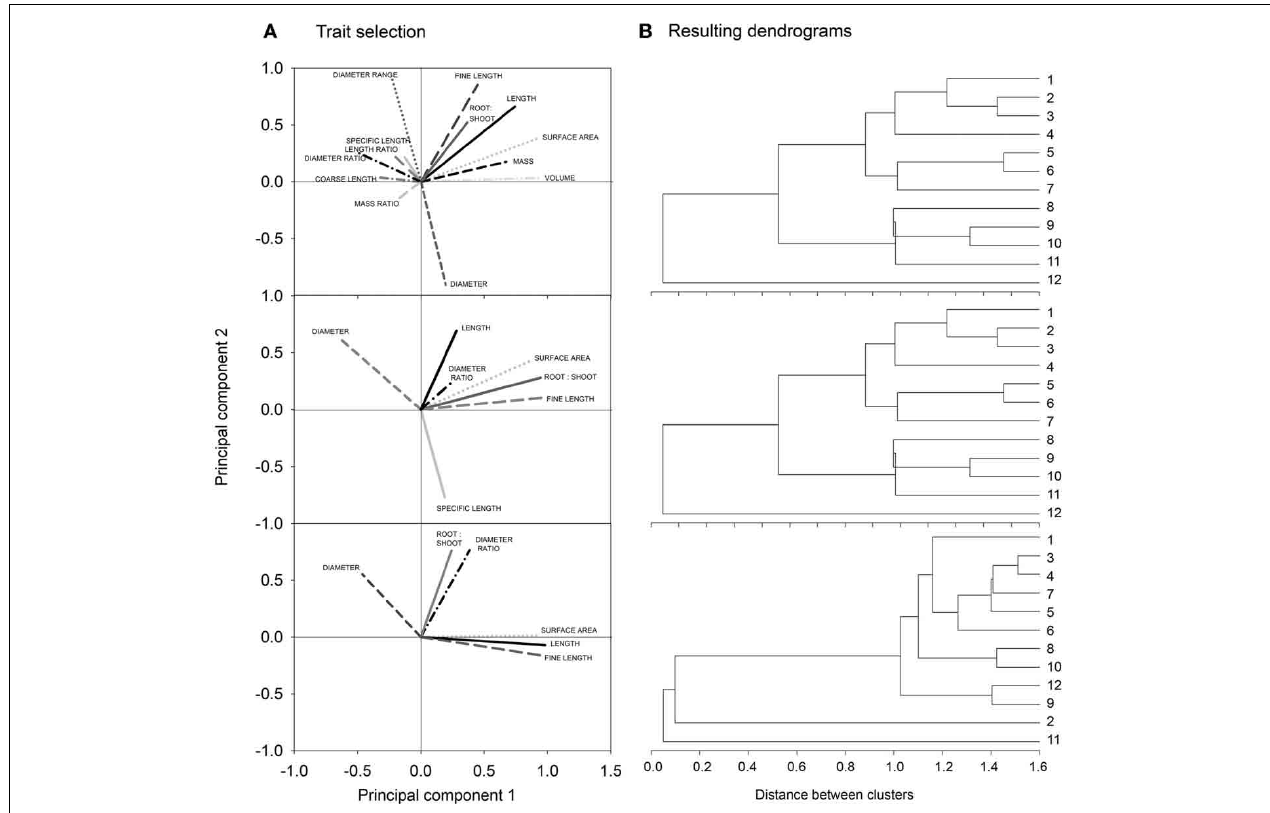
FIGURE A2 | Example for biplot inspection (A) to ensure congruency of subsequent grouping via cluster analysis (B). Biplots are used to visualize the mutual relation between different traits and to determine which traits are essential to conserve the overall variance in a multi-trait root system